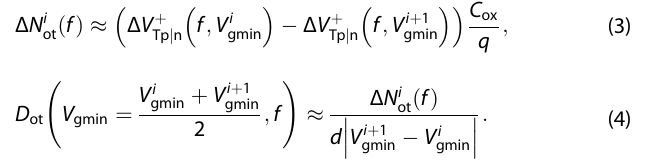
( f ) curves are proportional to the Tn ( f ) and Δ V (cid:2) ( f ) characteristics obtained for the Tp Tp is not accessible, we have to use the Δ V þ ( f ) Tp Tn